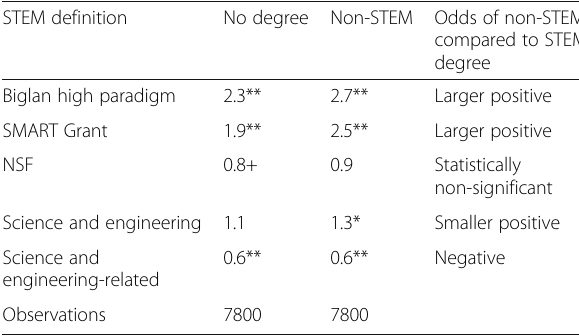
Table 1 Odds of attaining an undergraduate STEM degree — women vs. men — for five STEM